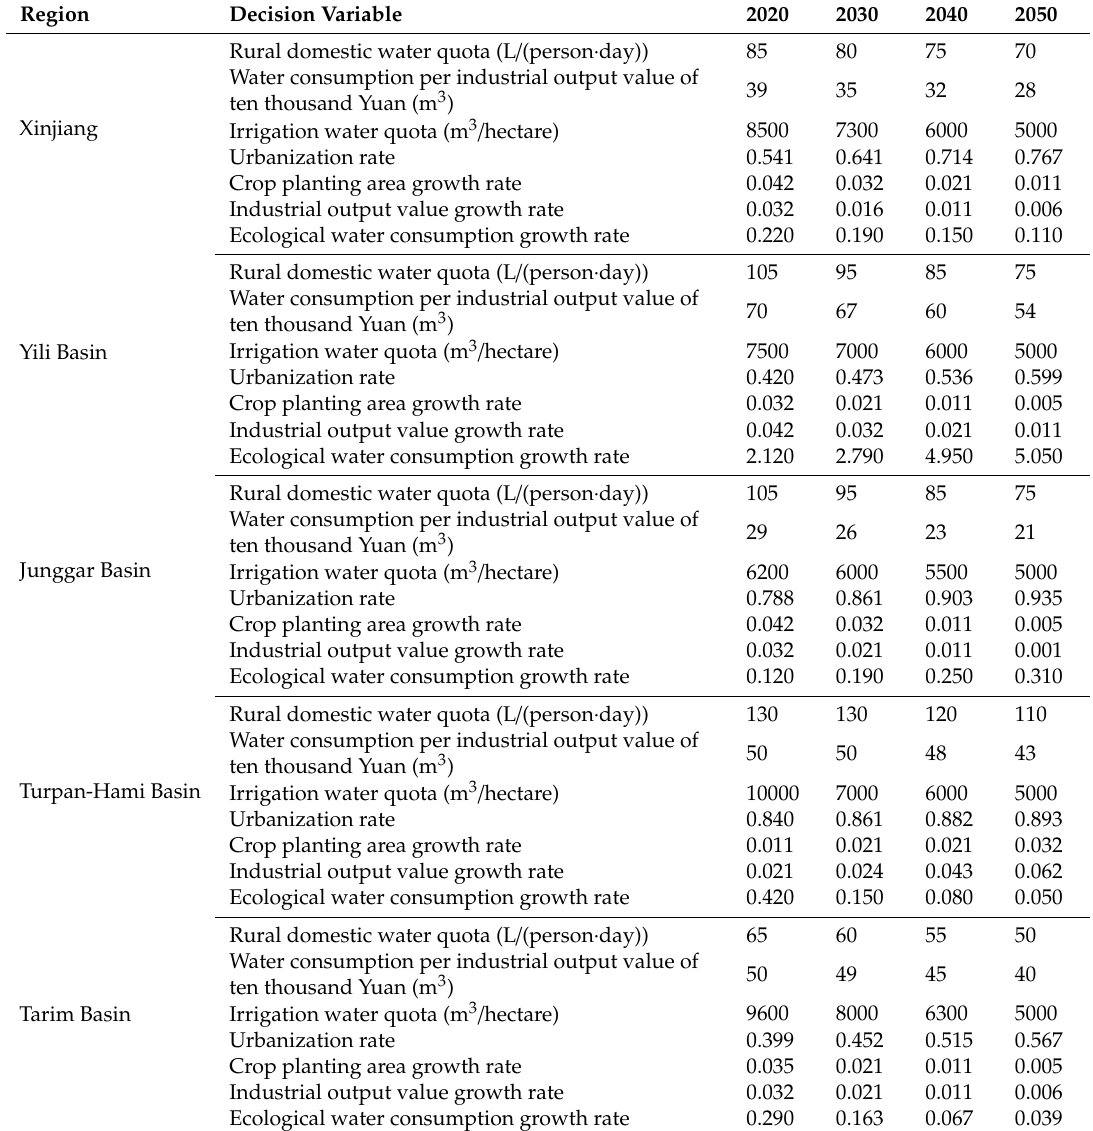
Table 4. Sustainable utilization plan of water resources for Xinjiang and its sub-regions in the next 30